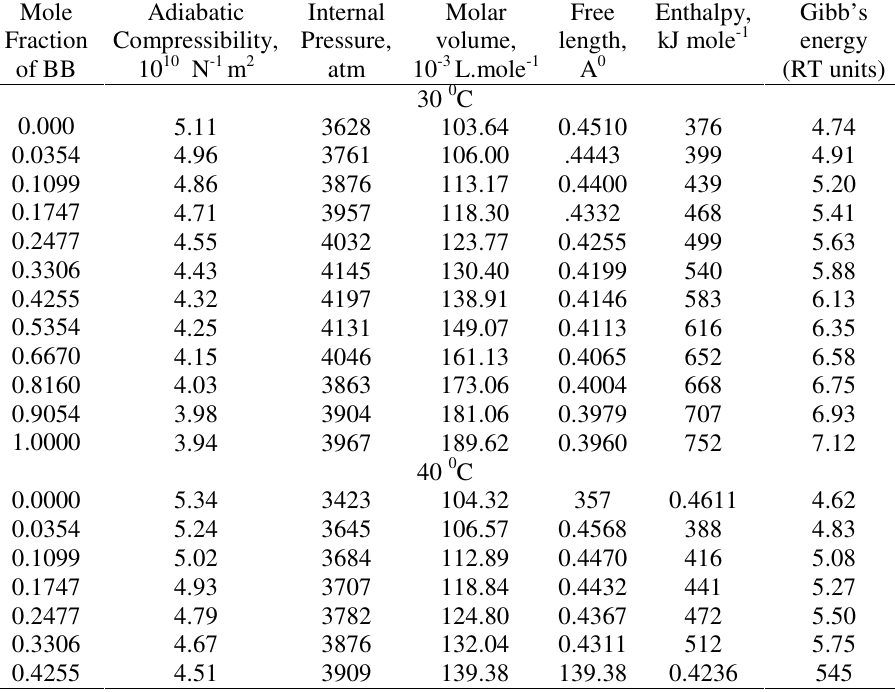
Table 4. Various parameters adiabatic compressibility, internal pressure, free volume, freelength, enthalpy and activation energy as a function of mole fraction of benzyl benzoate in benzyl benzoate + benzonitrile Mole